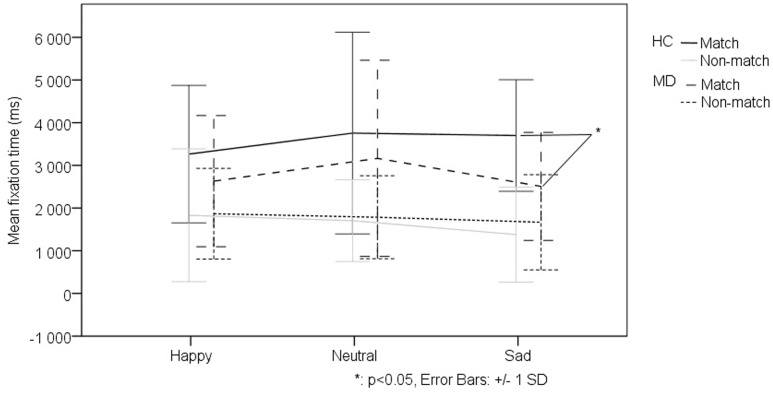
Effect of facial emotion on viewing patterns comparing the MD and HC groups in trials associated with virtual monetary reward. MD patients fixated on the sad match faces associated with monetary reward for a significantly shorter duration (M = 2291.124 ± 1304.498) than the HC group (t48 = -3,637, p = 0,001).